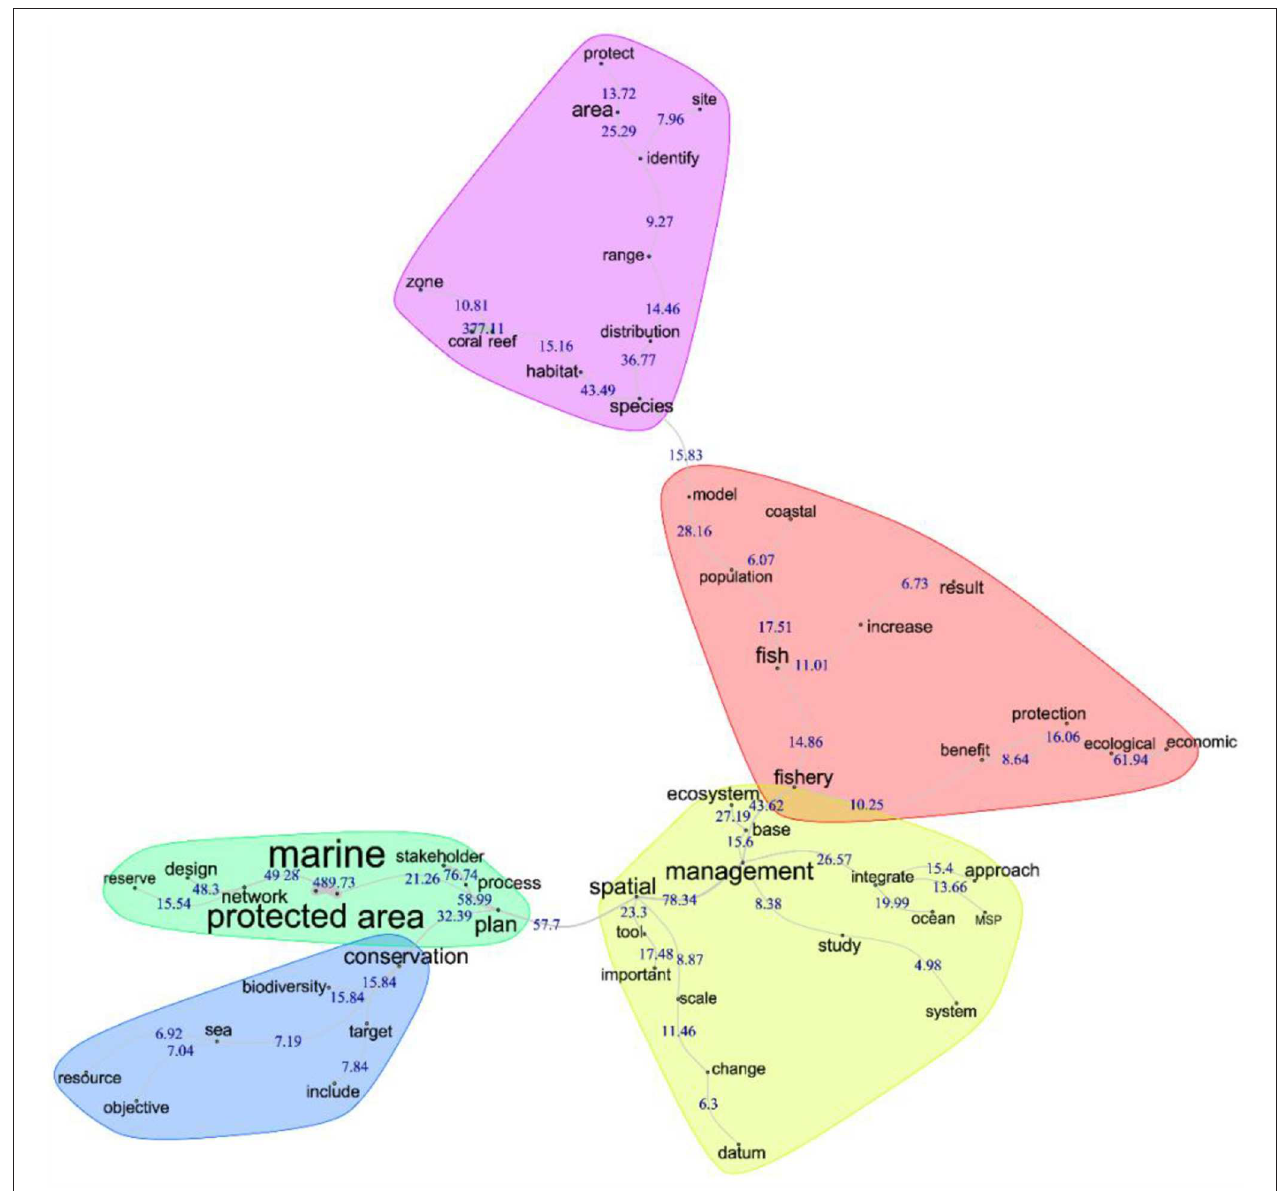
FIGURE 5 | Similarity analysis of studies outside Brazil, showing the formation of five classes of words/terms. The numbers represent the proximity between one word and a second word which is closest to the first one. The number indicates the distance between the words overall, showing their relationship in terms of proximity to each other. These words are interconnected by frequency, based on the theory of graphs and networks. The colors represent the classes, which were established according to the proximity of the words in the texts. Also, the largest words are the most frequently mentioned in the studies. This similarity analysis is related to the DHA in Figure 8